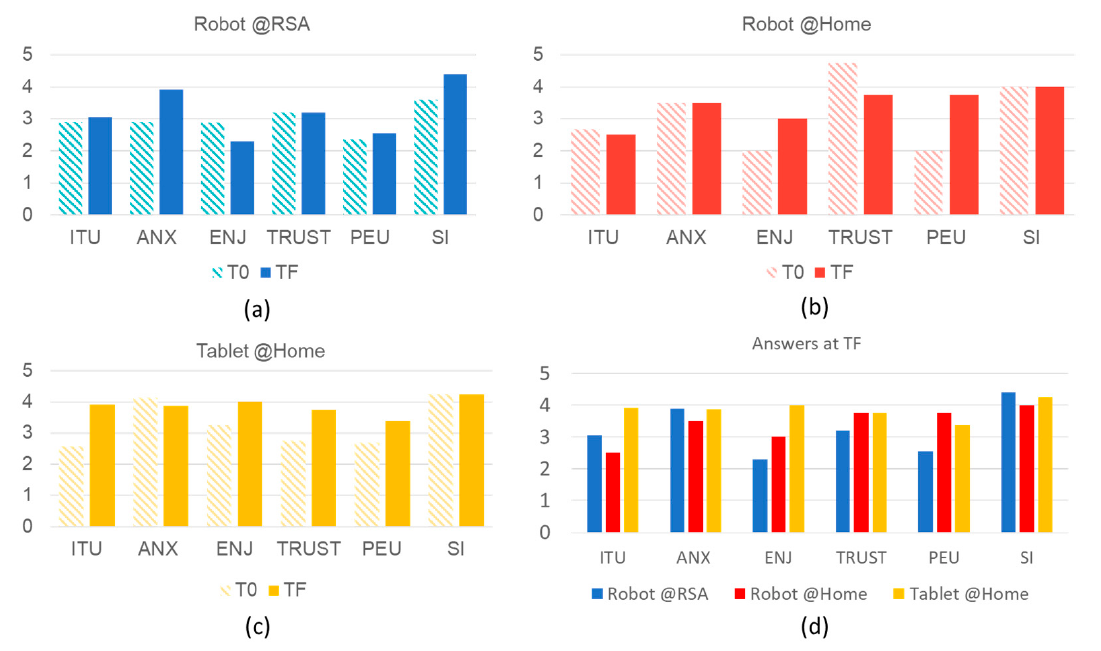
Figure 4. Results of the questionnaire for each construct at the beginning of the trial (T0) and at the end of the trial (TF) for the telepresence service: ( a ) average results of the telepresence service conducted with the robot in the residential facility; ( b ) average results of the telepresence service conducted with the robot in a private home; ( c ) average results of the telepresence service conducted with the tablet and EASI application in a private home; ( d ) comparison of the average results over the three applications at TF. ITU (intention to use); ANX (anxiety); ENJ (enjoyment); PEU (perceived ease of use); SI (social